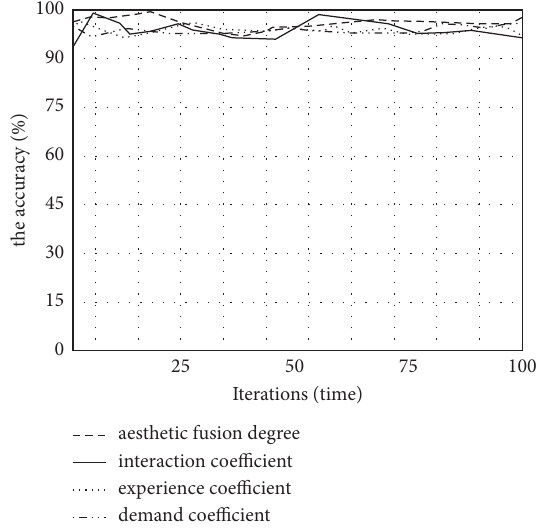
Figure 3: The accuracy of interaction coefficient, experience co- efficient, demand coefficient, and aesthetic fusion degree.